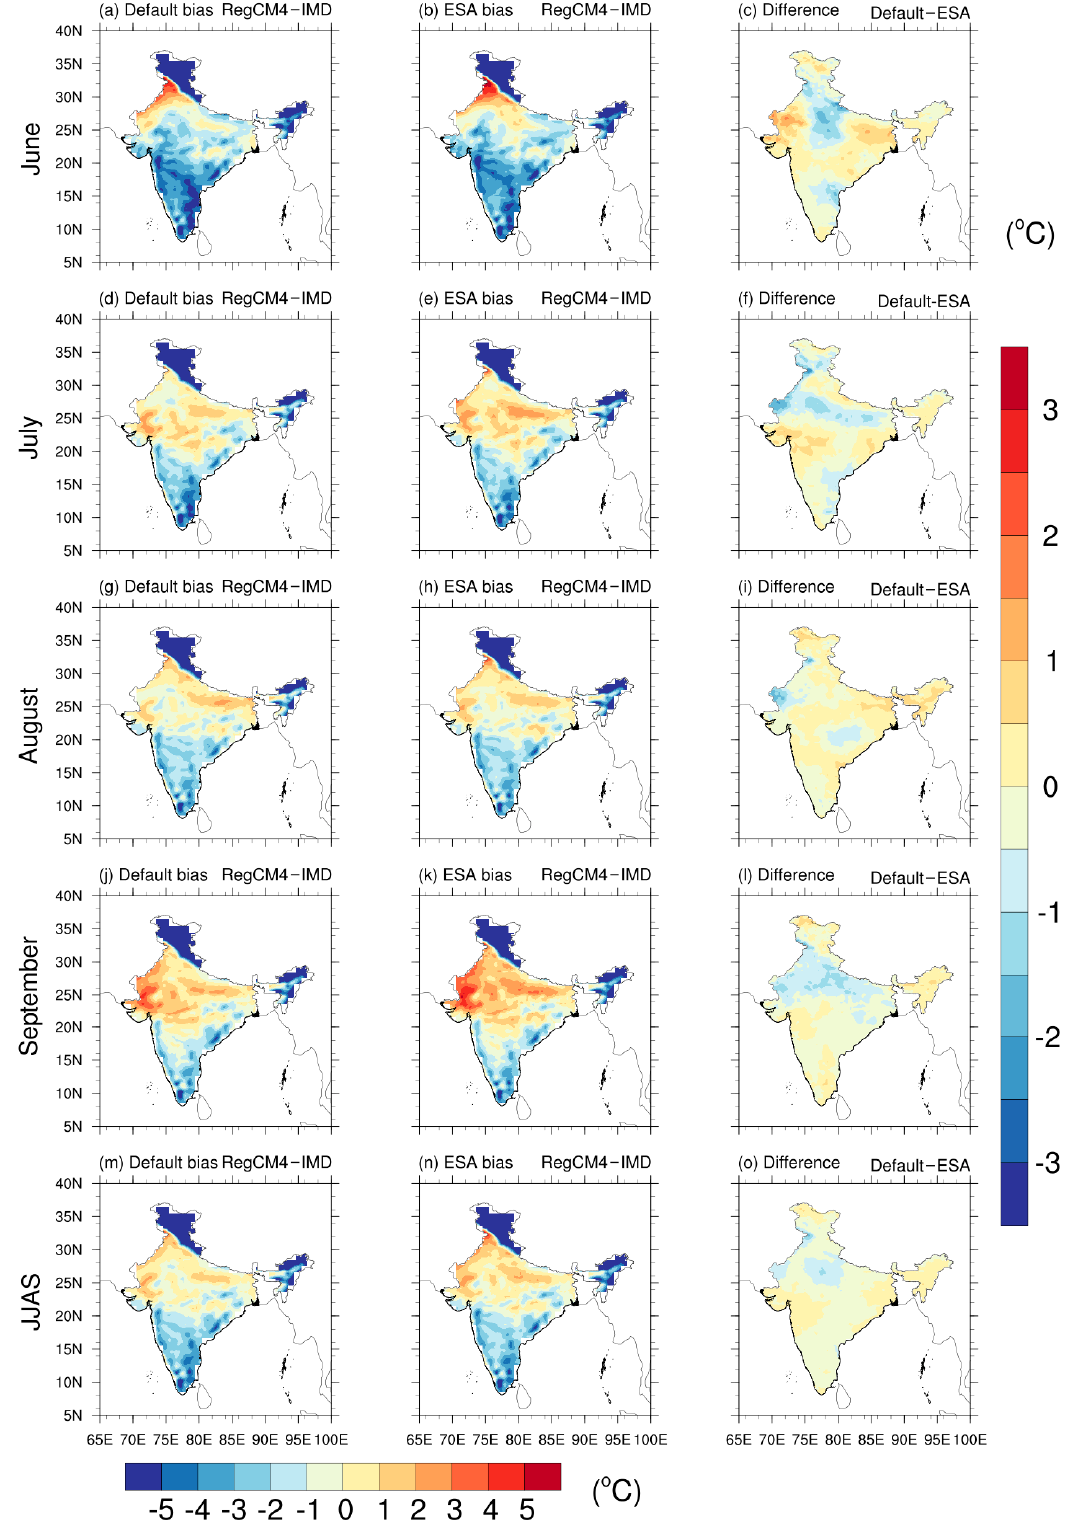
Figure 3. Same as Figure 2, but for the year 2011.